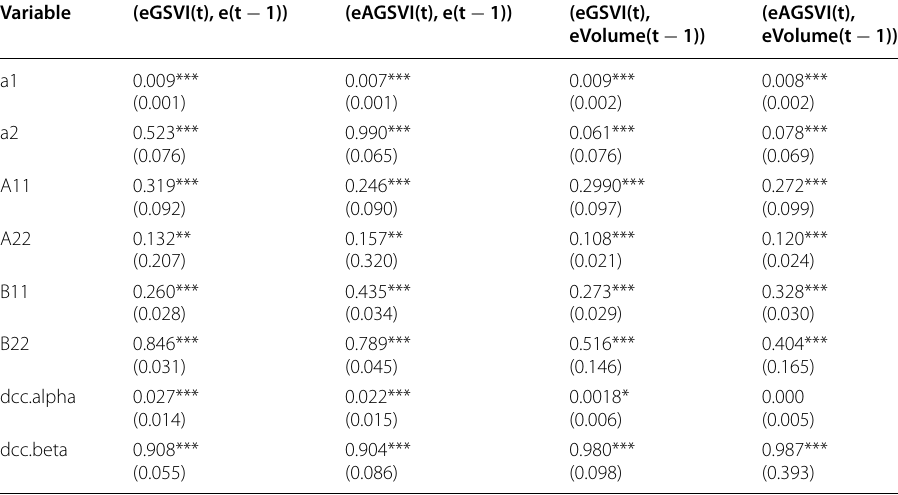
***, **, * denote statistical significance at a 1%, 5%, and 10% level, respectively. e(t), eGSVI (t), eAGSVI (t) and eVolume(t) are the innovations of Bitcoin returns, dlog_GSVI, AGSVI and dlog_volume at time t, which are estimated from ARMA‑GARCH models. (eGSVI(t),e(t 1)) represents DCC‑GARCH model of eGSVI(t) and e(t − −